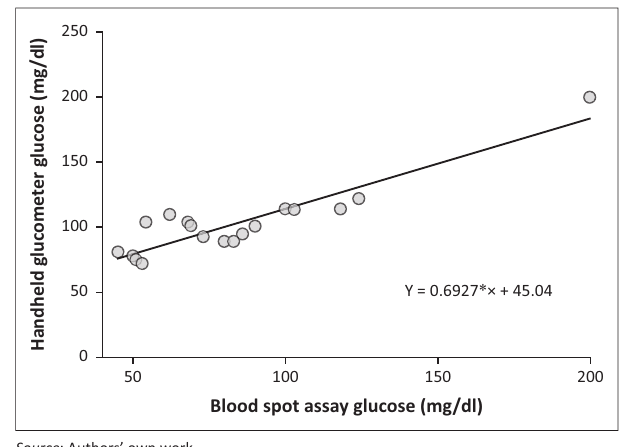
FIGURE 2: Subjective measures of mood, satiety and hunger: (a) score for hunger, (b) satiety, (c) feeling more alert and (d)